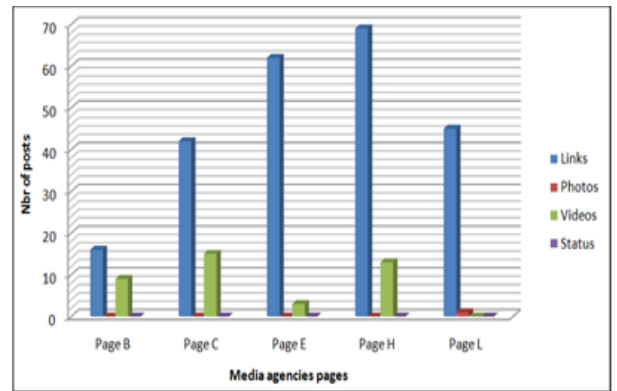
Fig. 1. The number of publications by type and by Facebook page